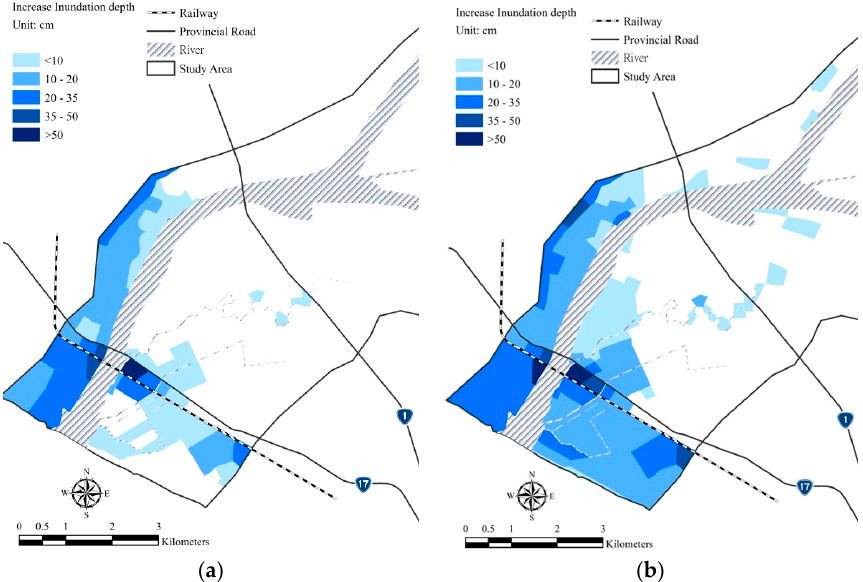
Figure 7. ( a ) Spatial distribution of inundation depth increase after land subsidence for a one-day storm under a 5-year return period; ( b ) Spatial distribution of inundation depth increase after land subsidence combined with climate change for a one-day storm under a 5-year return period.